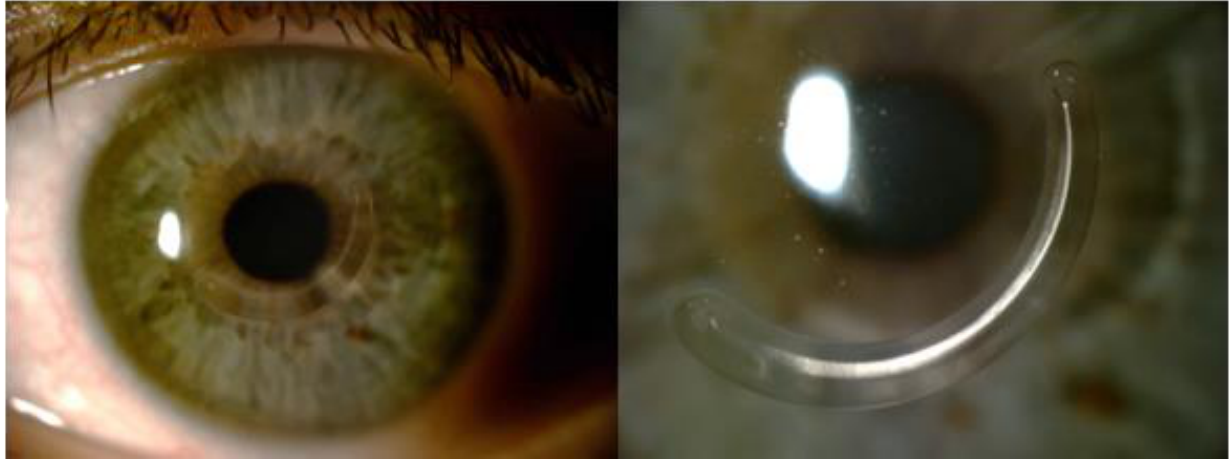
Figure 1. Slit-lamp photography 6 months after AJL PRO + implantation. Base width gradually increases from 800 to 1200 µ m and thickness increases from 150 to 250 µ m, with a diameter of 5 mm and arc length of 160 degrees.